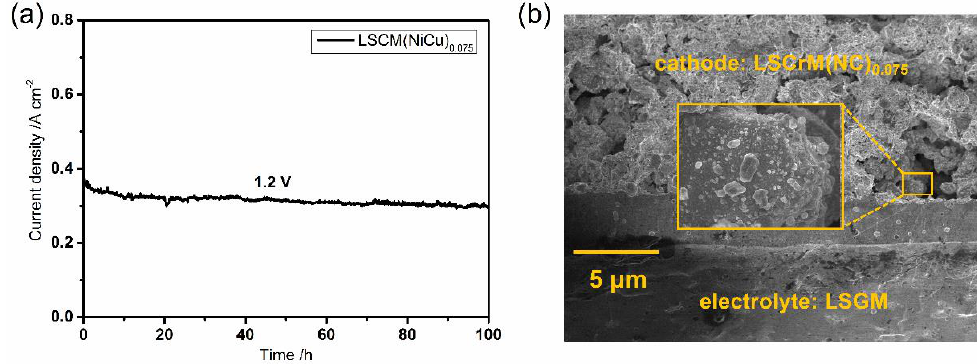
Figure 7. Long − term tests and morphology. ( a ) Long − term performance of electrolysis of CO 2 100 h and ( b ) micrographs after electrolysis.